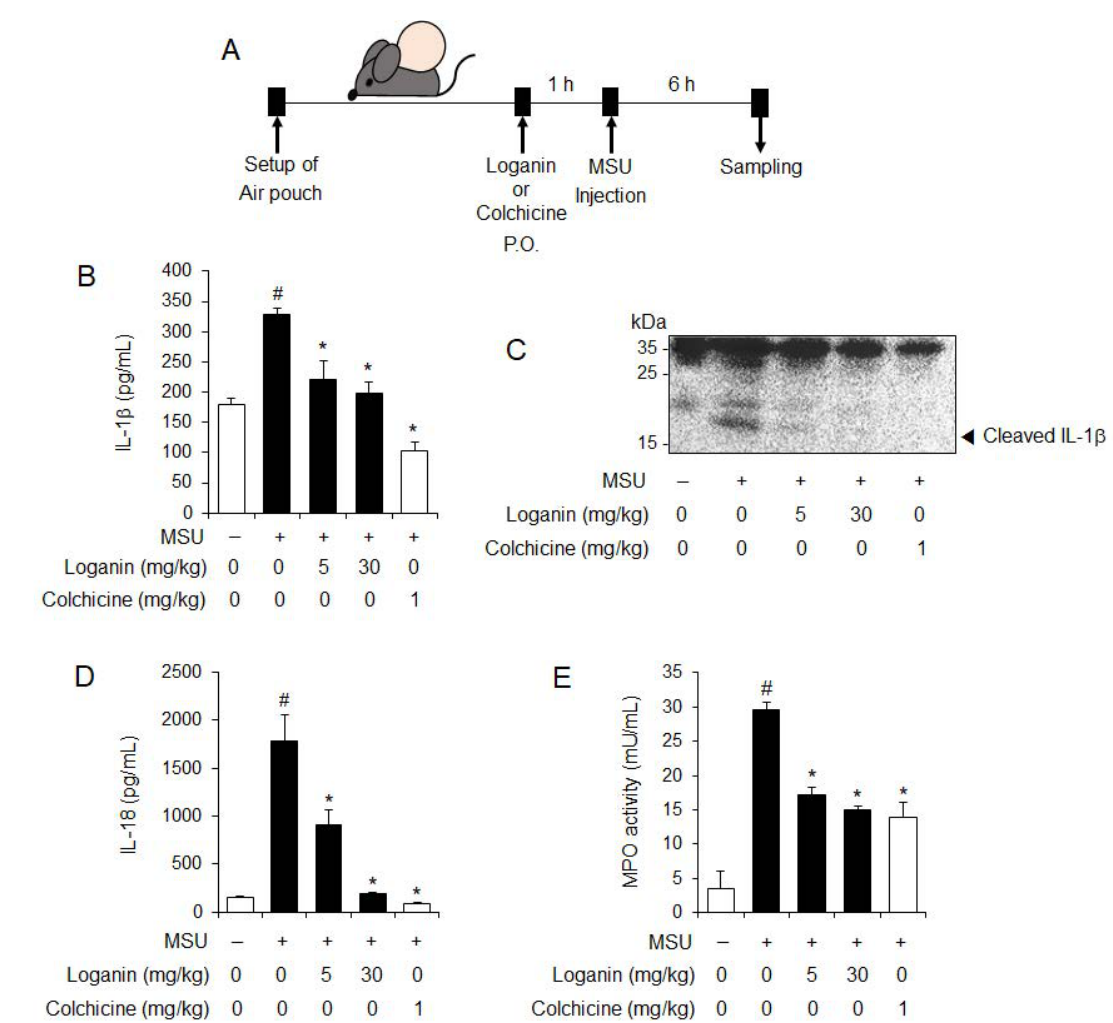
Figure 2. Oral administration of loganin inhibits MSU crystals-induced NLRP3 inflammasome activation and inflammation in a mouse air pouch model. Air pouches were formed on the mouse back by injecting air twice. Loganin (5 or 30 mg/kg) or colchicine (1 mg/kg) was orally administered. After 1 h, MSU crystals (3 mg/mL in PBS/mouse) or PBS alone were injected into the air pouches. After 6 h, the pouch exudates were harvested and the supernatants were analyzed. ( A ) Experimental scheme. ( B ) ELISA for IL-1 β . ( C ) Immunoblotting for IL-1 β . ( D ) ELISA for IL-18. ( E ) Myeloperoxidase (MPO) activity, which reflects neutrophil recruitment, was assessed in the air pouch exudates. The values in the bar graphs represent the means ± SEM ( n = 5 mice); # significantly different from vehicle alone, p < 0.05; * significantly different from MSU alone, p <